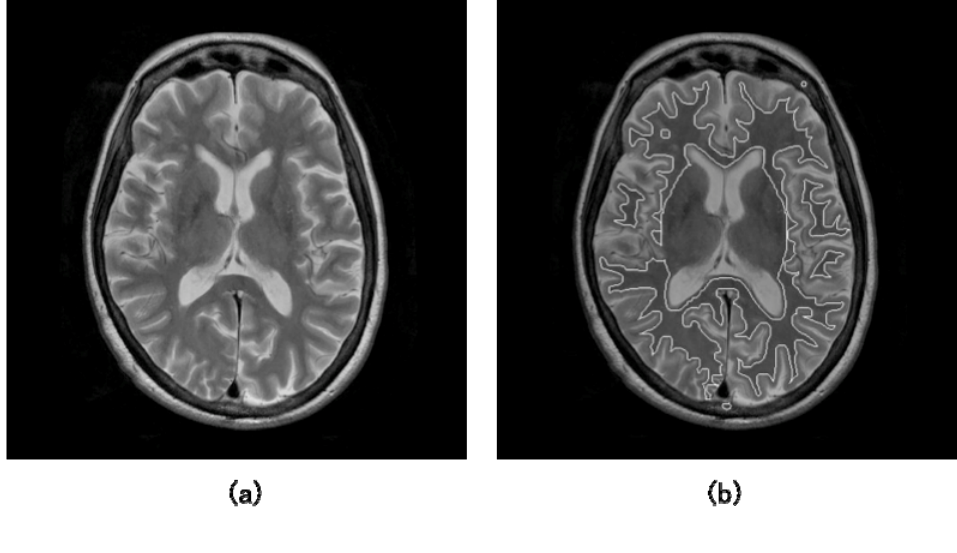
Figure 7. Illustrations of: (a) an original T2-weighted image and (b) white matter regions segmented by a level set method